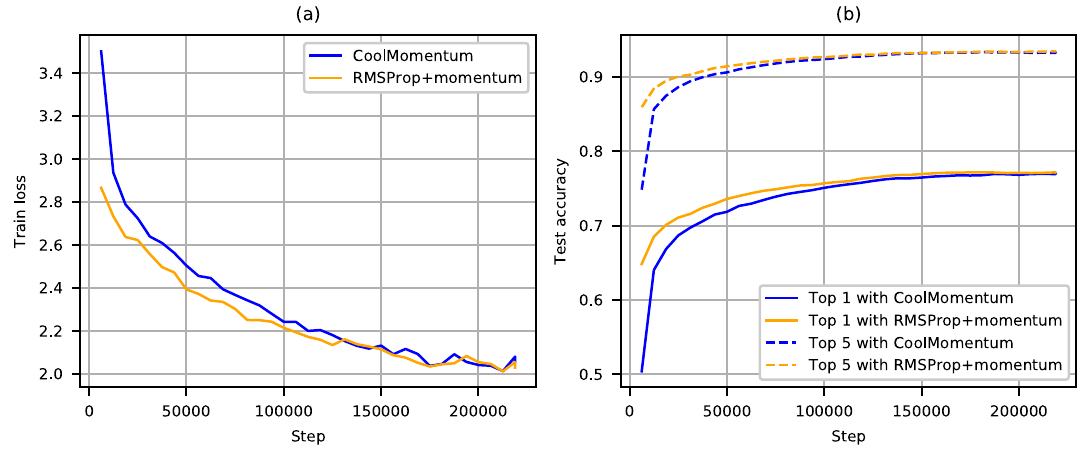
Figure 2. Imagenet classification with Efficientnet-B0: training loss ( a ) and test accuracy ( b